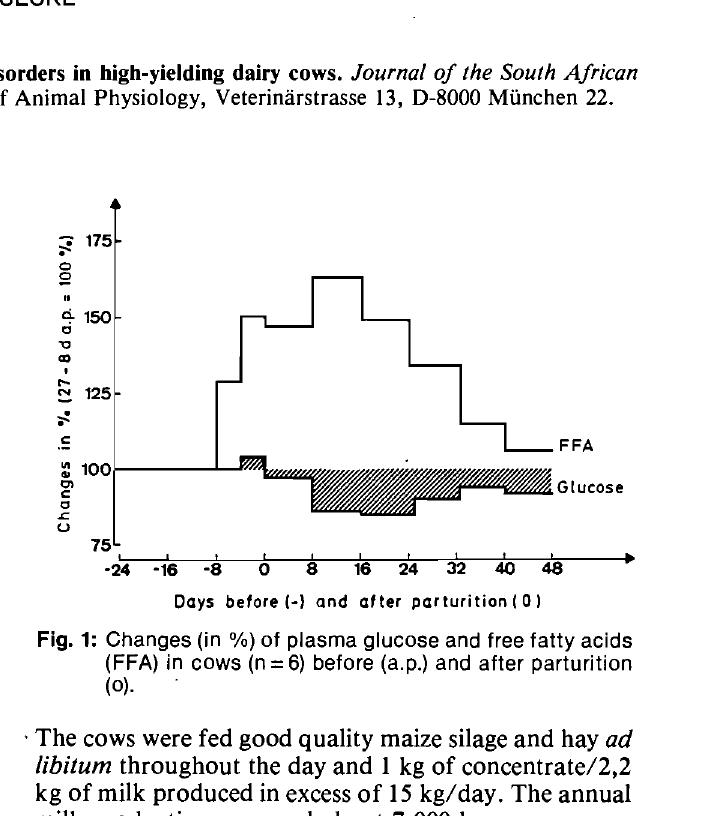
Table 1: Influence of energy status during the feeding interval on the mobilization of free fatty acids (FFA) from adipose tissue lipds